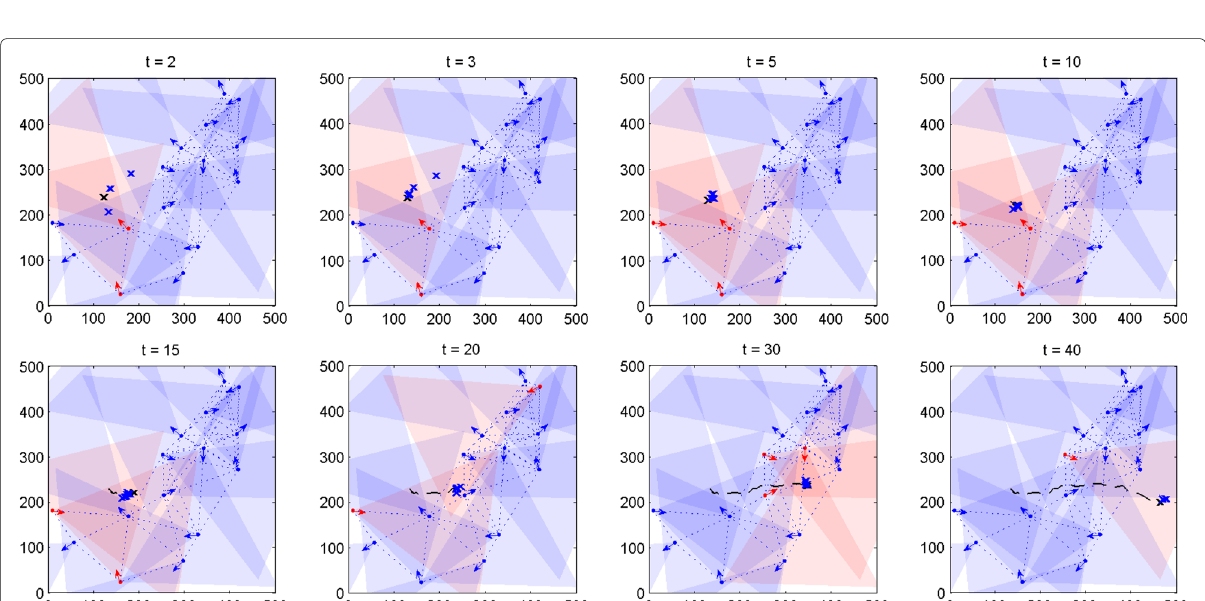
Fig. 4 Snapshots of the target position estimates of all the nodes (blue x), together with the target trajectory up to the given time instants (black dashed line) and the current target positions (black x). Cameras’ positions, orientations, and FoVs are also shown (dots, arrows, and triangles, respectively)—in red for cameras that observe the target, in blue for the others. Communication topology is represented by dotted